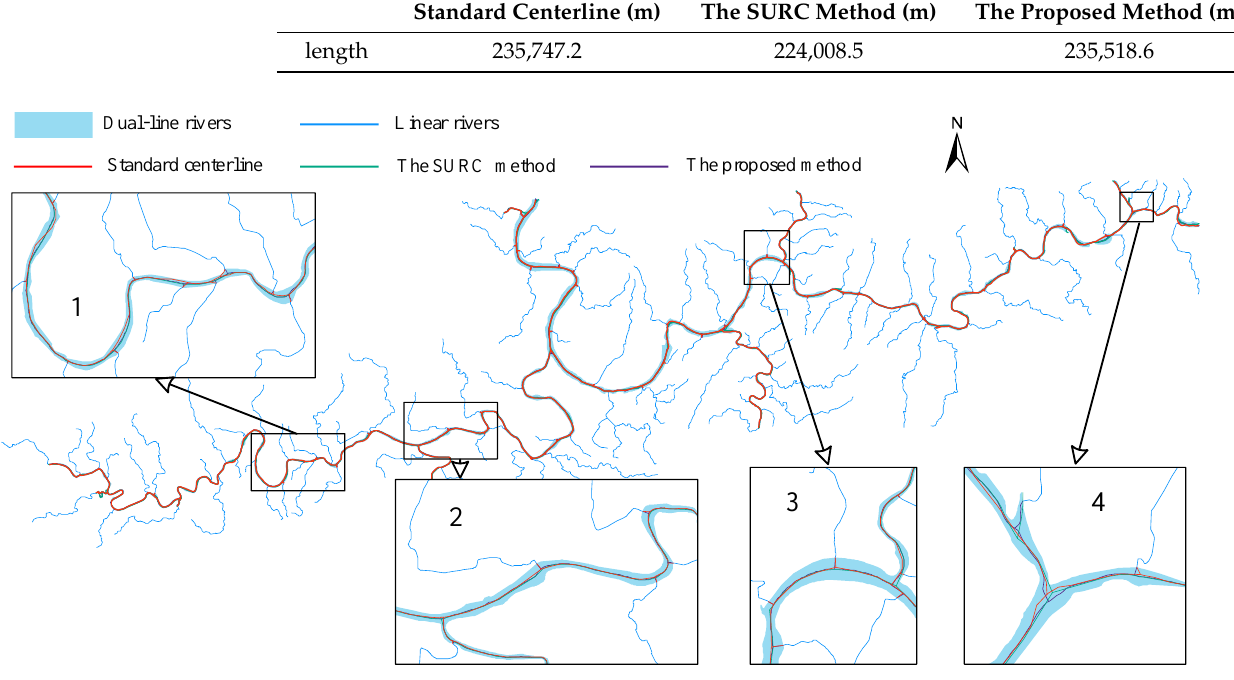
Figure 15. Collapse results of the proposed method and the superpixel river collapse (SURC) method are superposed and compared with the standard centerline.